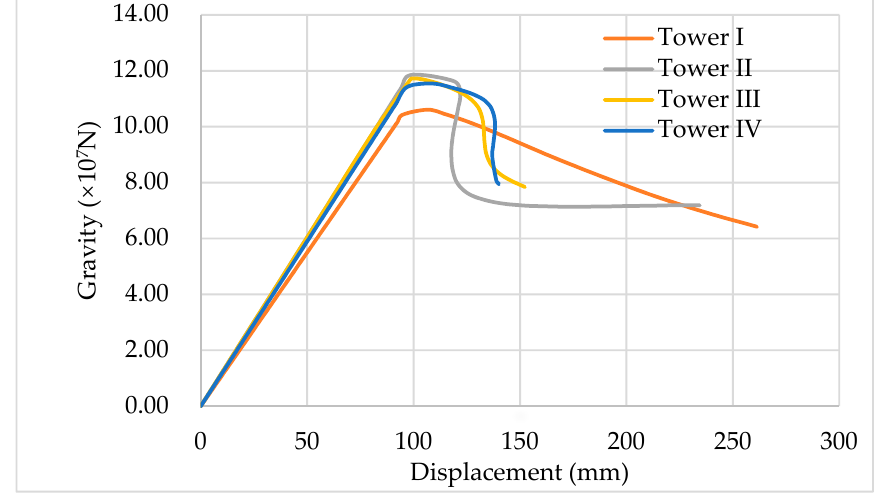
Figure 16. Gravity versus displacement of Towers I, II, III, IV under the gravity of wind turbines.